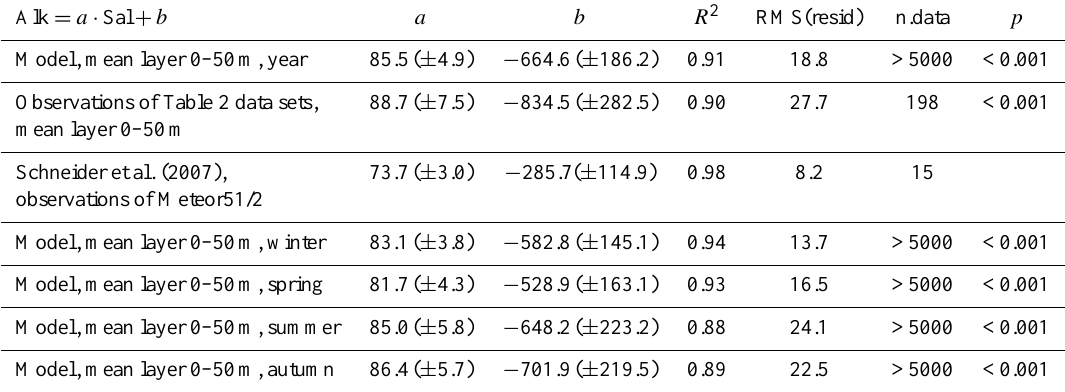
Table 3. Coefficients of the alkalinity vs. salinity linear regression of the surface layer (mean 0–50m) computed for the model results (year and seasonal averages) and for observations of data set listed in Table 1. Coefficients of Schneider et al. (2007) regression are also reported.